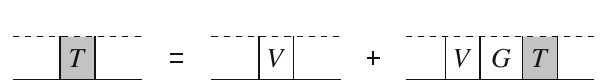
Fig. 2 Diagrammatic representation of the meson–baryon scattering equation. The dashed and solid lines denote the pseudoscalar mesons and the octet baryons, respectively